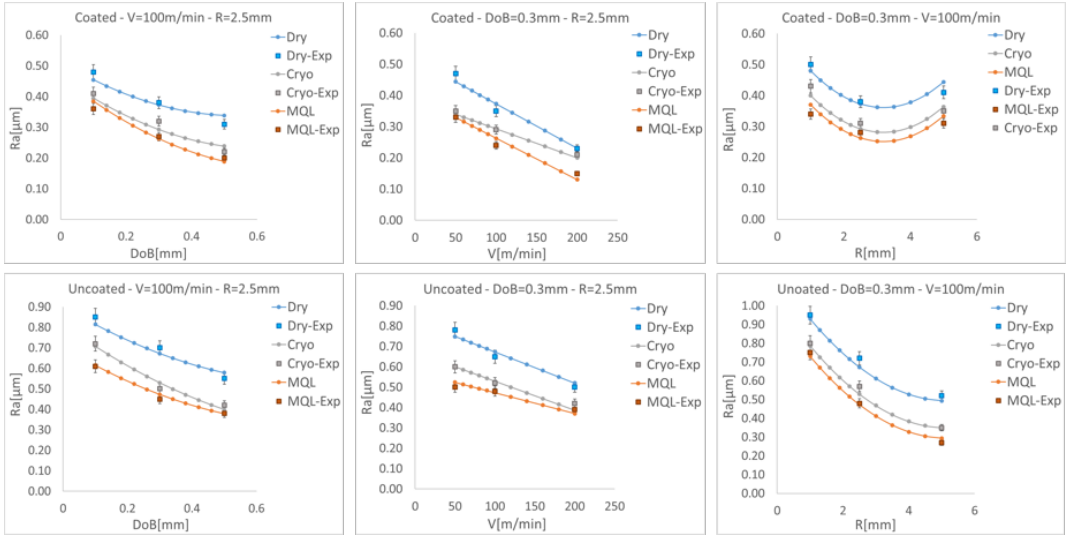
Figure 4. Roughness prediction for selected cases.